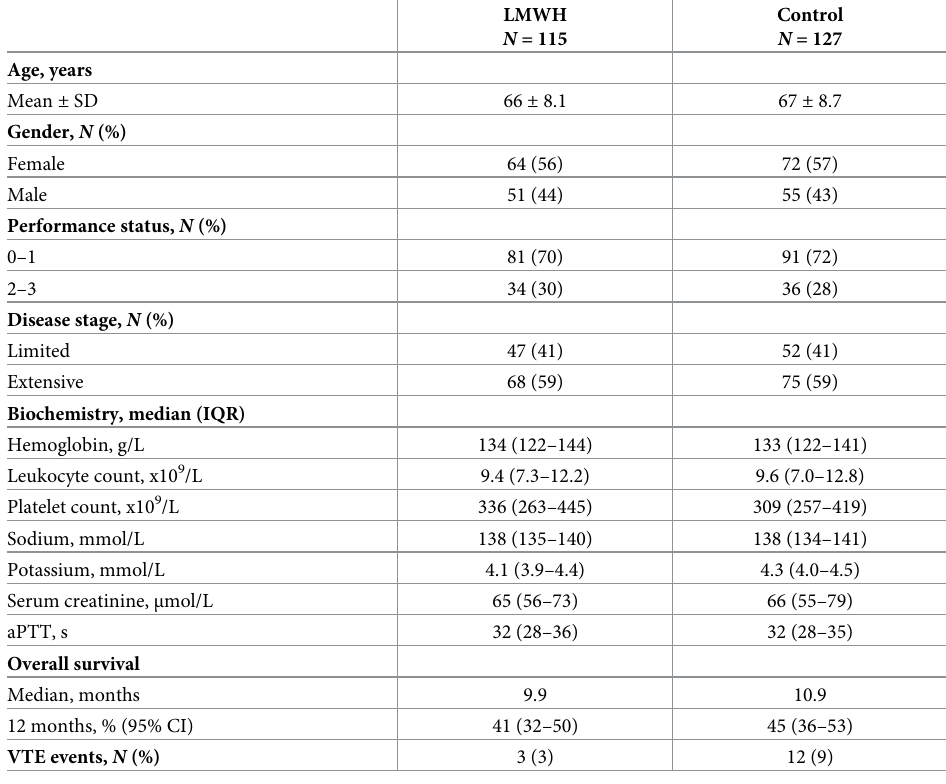
Table 1. Baseline characteristics of the study